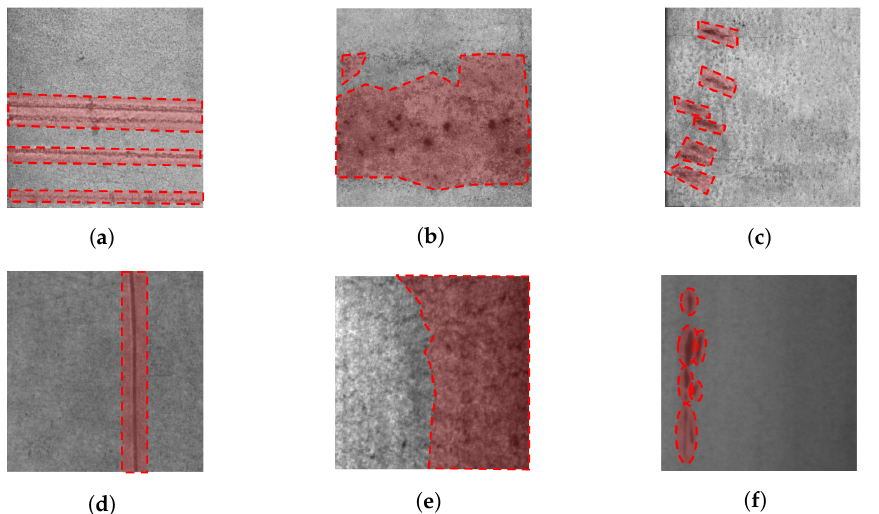
Figure 1. Samples of four types of steel surface defects. ( a ) finishing roll printing; ( b ) oxide; ( c ) patches; ( d ) scratches; ( e ) crazing; and ( f ) inclusions.